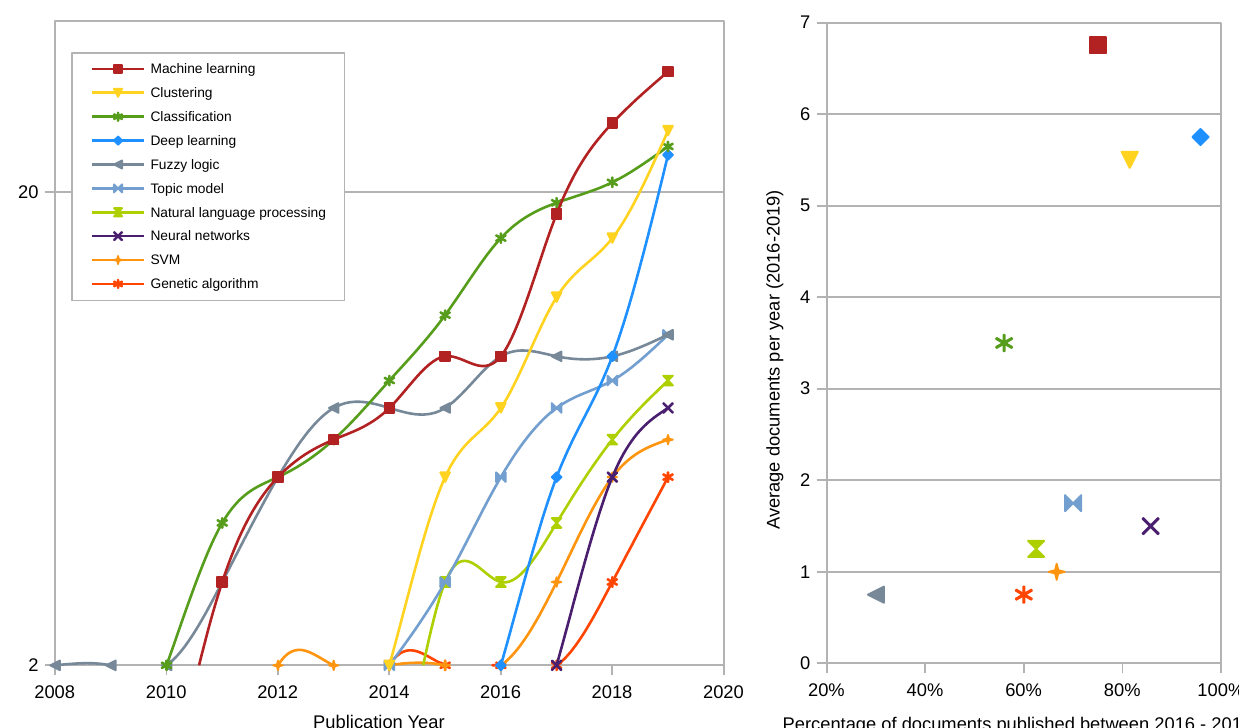
Figure 8. The relevance of machine learning approaches in the implementation of recommendation and emotion recognition